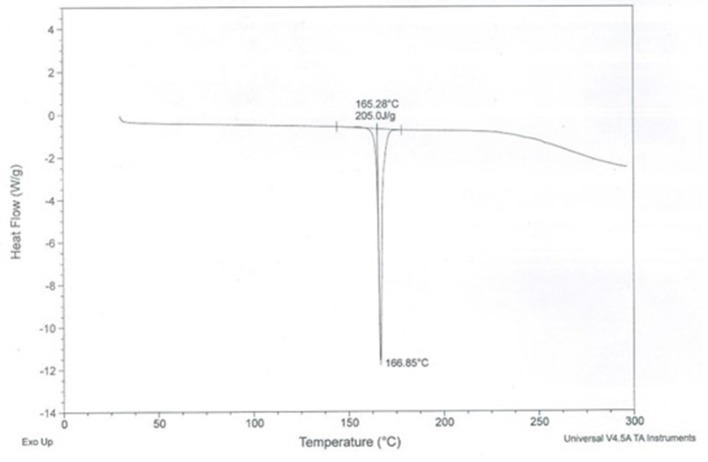
DSC thermogram of CA-PLGA nanoparticle.